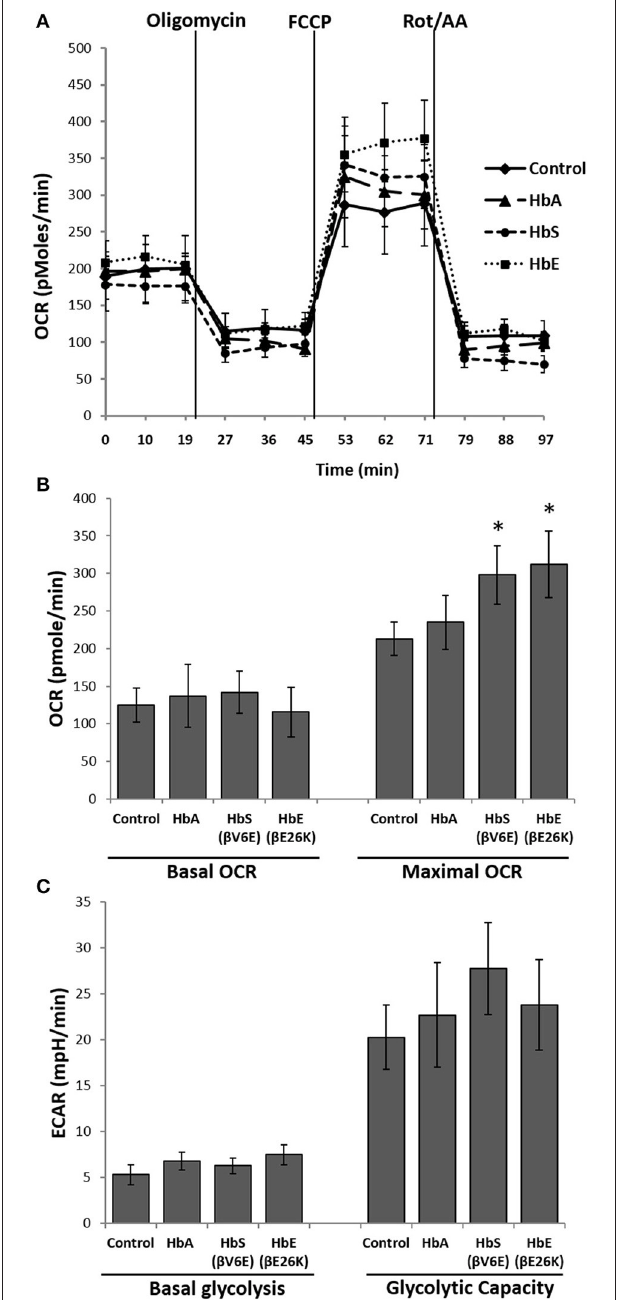
FIGURE 2 | Effect of mutant hemoglobins on pulmonary endothelial bioenergetics. HPAEC were exposed to ferrous forms of HbA, HbS, or HbE at equimolar concentration (100 µ M) for 12h. Mitochondrial oxygen consumption rates (OCR) and extracellular acidification rates (ECAR) were measured in real time using XF24 extracellular flux analyzer. (A) A representative OCR plot showing the components of mitochondrial bioenergetic parameters. Average OCR values from individual set of experiments repeated four times were plotted to make bioenergetic profile of each Hb treated HPAEC. (B) Basal and maximal OCR obtained from HPAEC following exposure to Hb ( N = 4). (C) Basal glycolysis rate and glycolytic capacity were calculated from HPAEC following exposure to Hb ( N = 3). Differences between two different groups were compared using a paired Student’s t -test. * P < 0.05 vs.